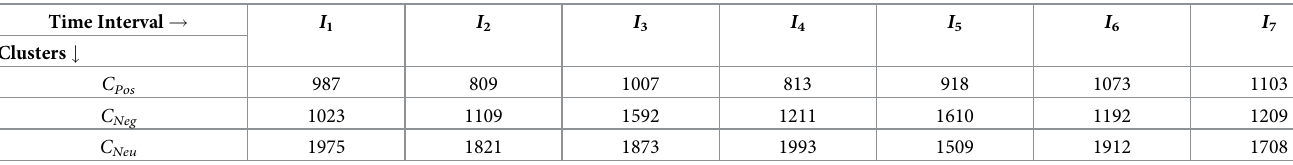
Table 7. Overall sentimental clusters size for top- k = 3 trending topics.